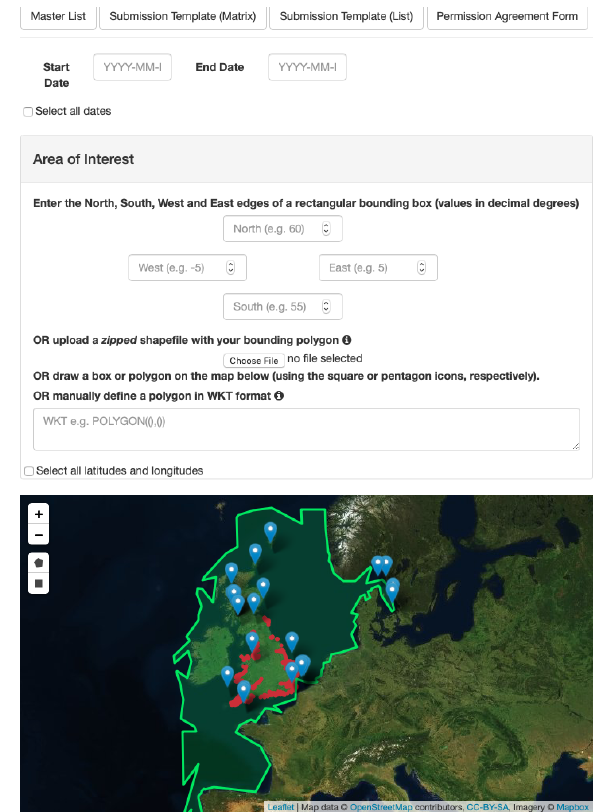
Figure 4. The Plankton Lifeform Extraction Tool. Screenshot of the Plankton Lifeform Extraction Tool